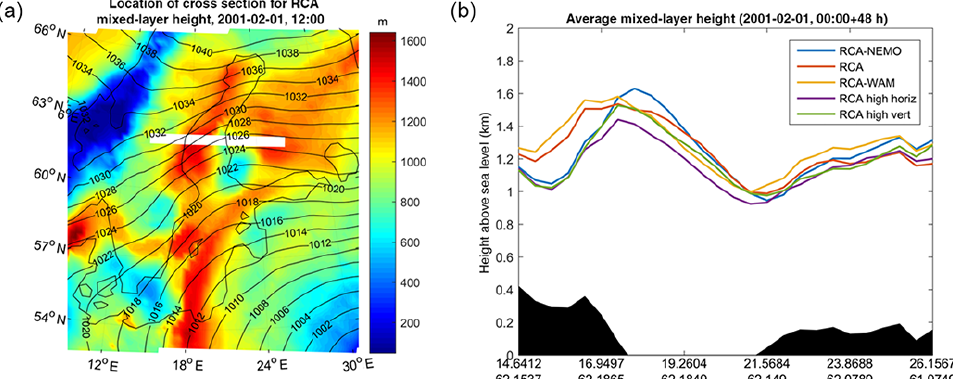
Figure 9. Boundary layer height horizontally for RCA (a) and the 2-day mean in a cross section for all models (b) for case